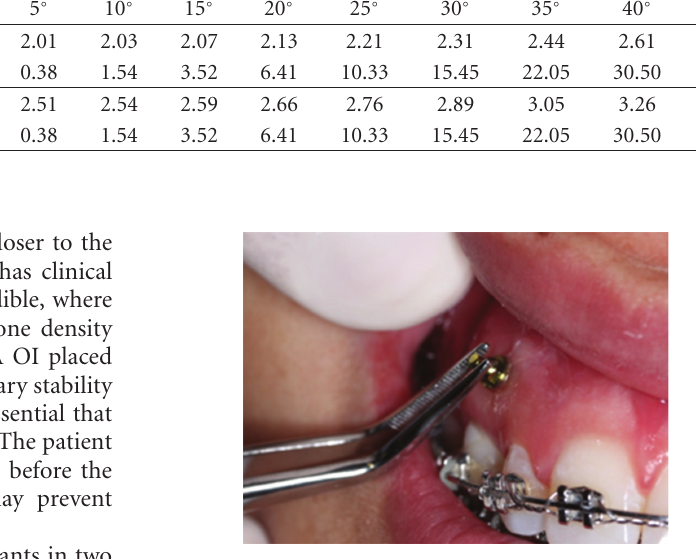
Figure 7: Primary stability evaluation with a tweezer immediately after implant insertion.